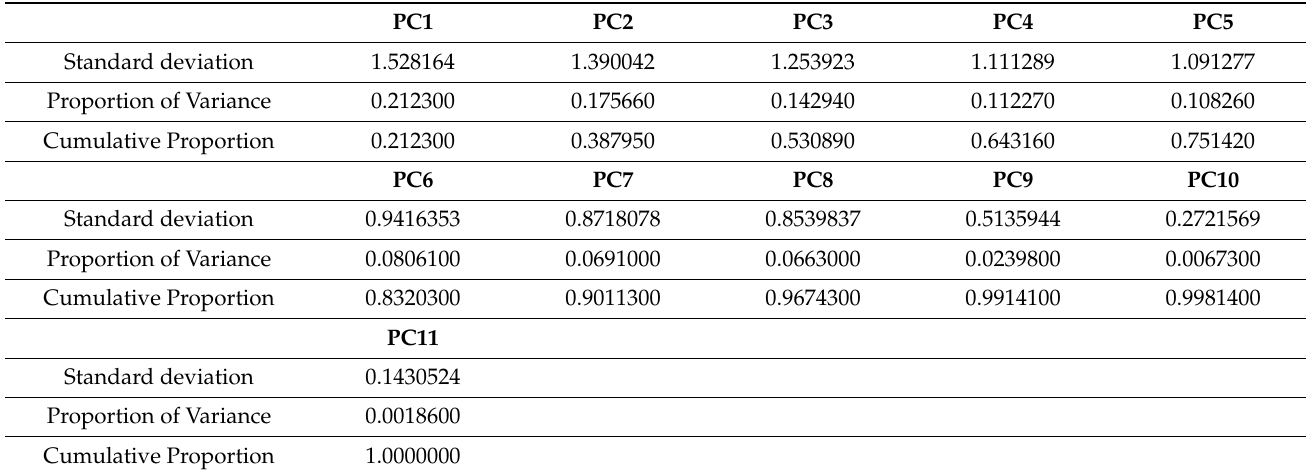
Table 2. Variance in main components.